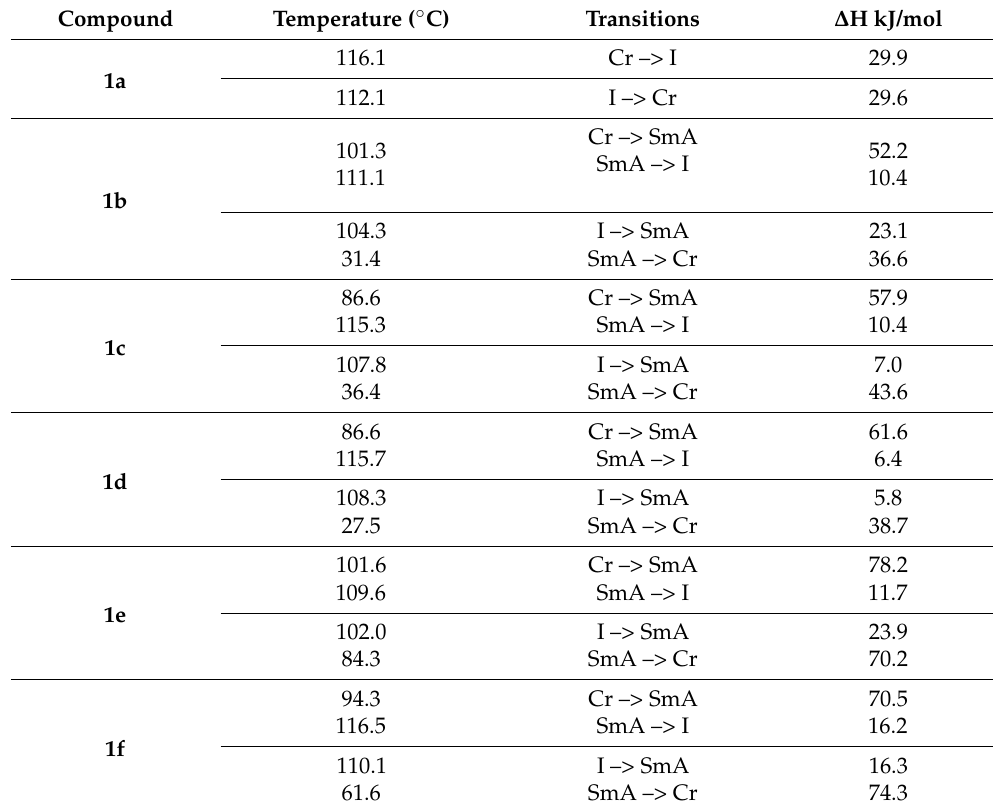
Table 2. Phase transition temperatures of compound 1(a – f) . Reprinted/adapted with permission from Ref. [25]; published by Elsevier, 2011.